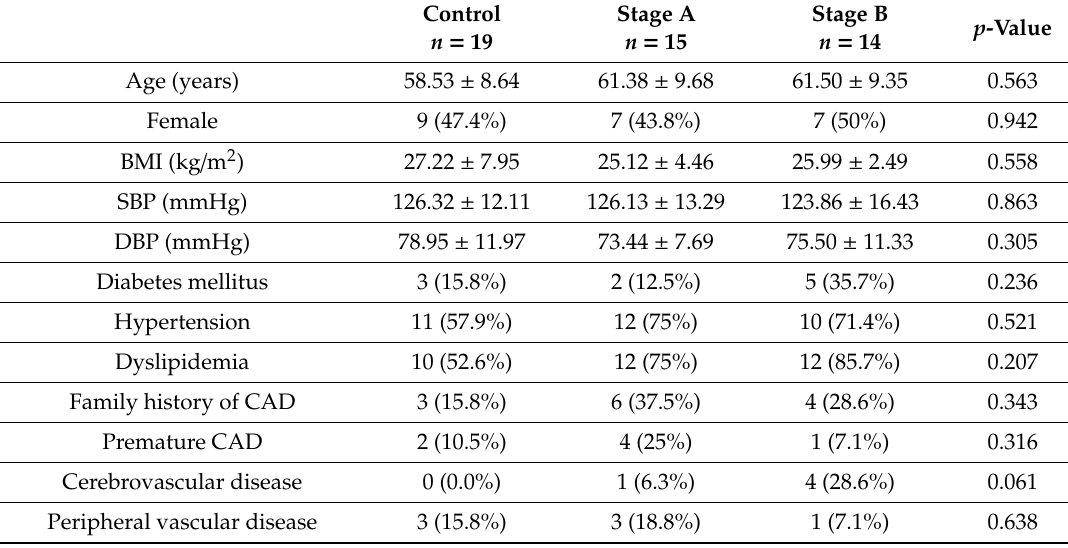
Table 1. Baseline